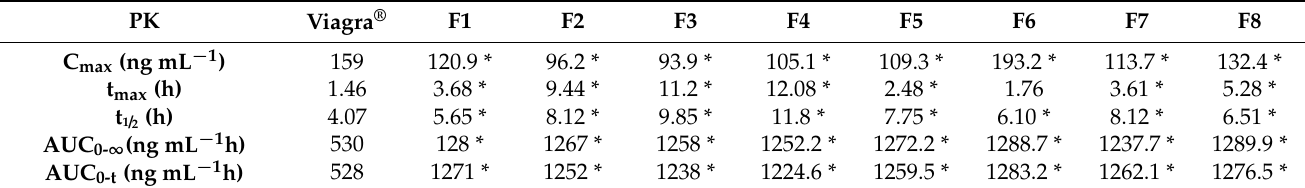
Table 3. Pharmacokinetic parameters of SDF after in silico oral administration of SDF in controlled release polymer matrices containing various drug to polymer ratios. Data obtained after PBPK modeling of each formulation.